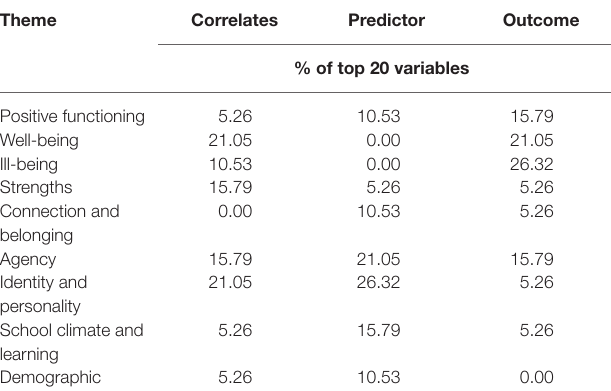
TABLE 7 | Thematic categories classified as correlates, predictor variables, or outcome